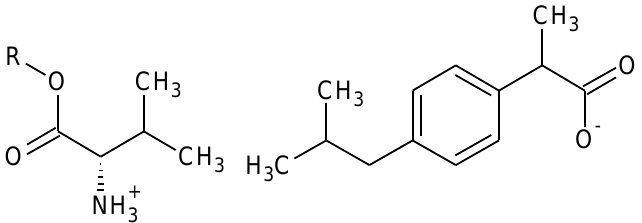
Figure 1. The structures of ibuprofen salts with L-valine alkyl esters, R = C 1 –C 8.